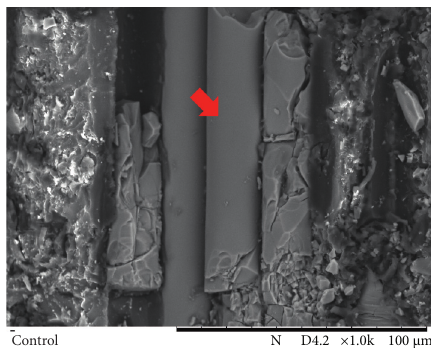
Figure 4: SEM image of a post surface from the blasting and silanization group (1000x magnification). Areas with an irregular morphological aspect, indicating surface roughness, which facili- tated wetting by silane and the flow of resinous cement, are visible